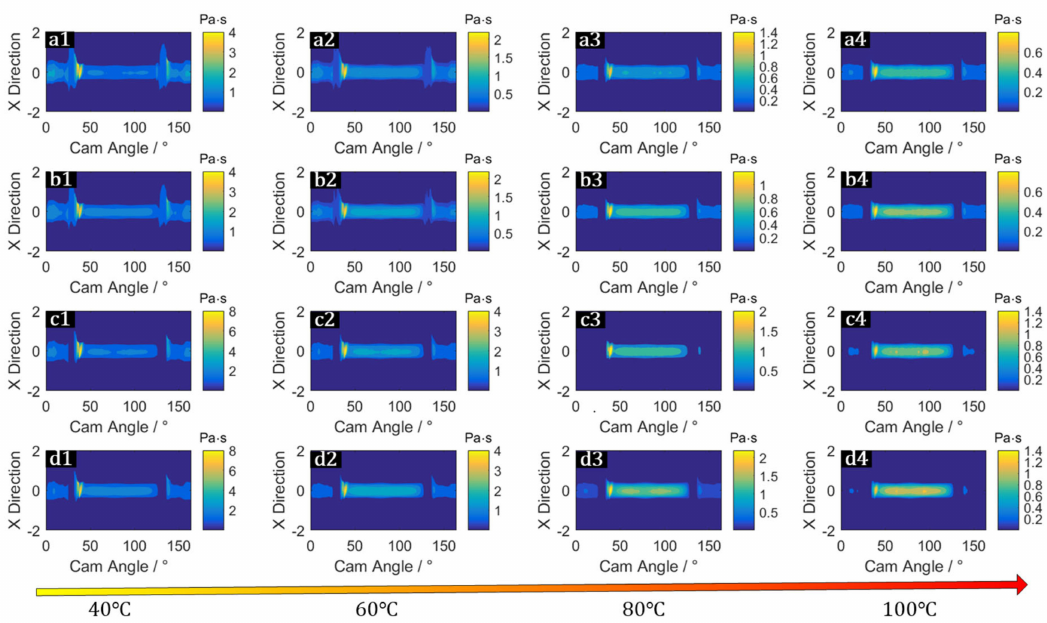
Figure 13. The lubricant viscosity distributions at various ambient temperatures during a cam cycle under the heavy load: ( a1 )–( a4 ) coated surfaces with 0.165 µ m roughness, ( b1 )–( b4 ) coated surfaces with 0.257 µ m roughness, ( c1 )–( c4 ) uncoated surfaces with 0.165 µ m roughness, and ( d1 )–( d4 ) uncoated surfaces with 0.257 µ m